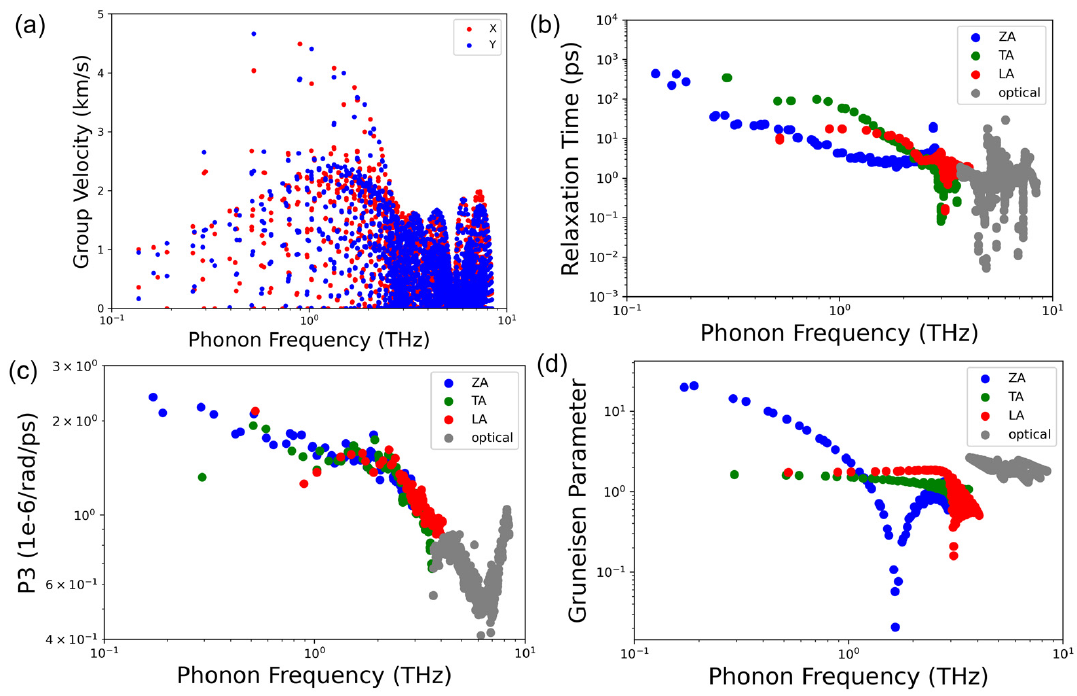
Figure 4. Scatter plots of ( a ) the phonon group velocity as a function of phonon frequency, ( b ) the phonon relaxation time, ( c ) the three-phonon scattering phase space (P3 in the figure) and ( d ) the Grüneisen parameters for different acoustic phonon modes as well as the optical phonon as a function of frequency at room temperature.